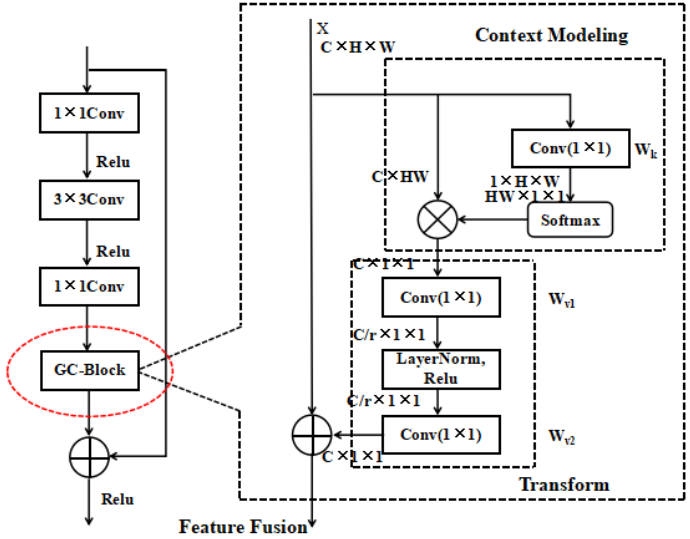
Figure 3. Improved backbone network structure .